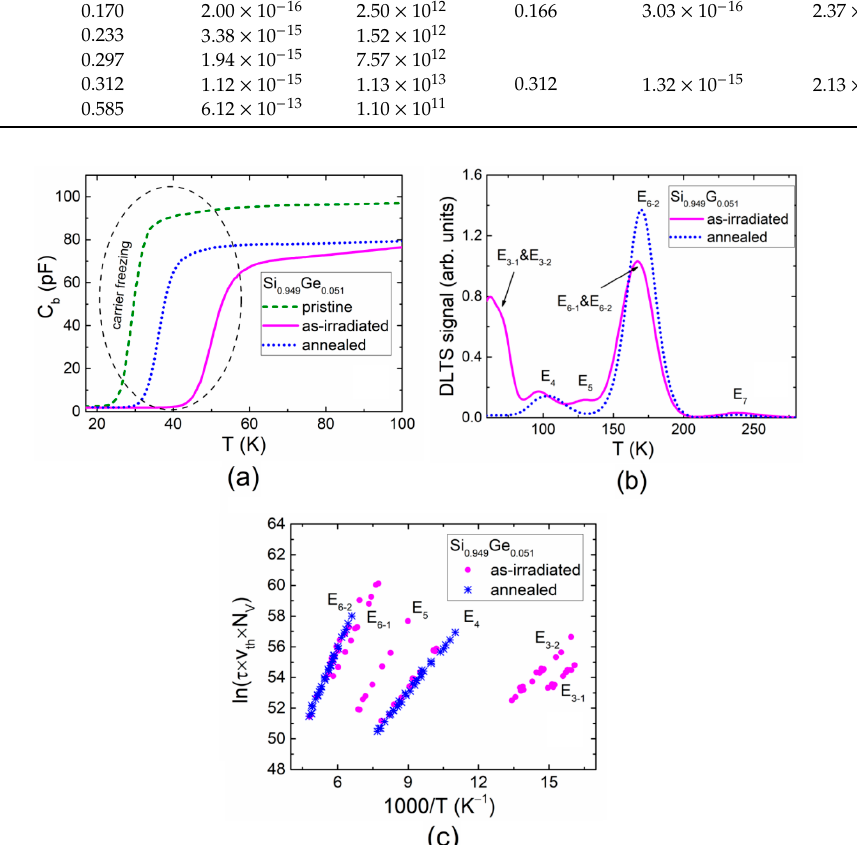
Figure 3. ( a ) The barrier capacitance dependence on temperature (C b –T) obtained for pristine, 5.5 MeV electron irradiated and the subsequently annealed Si 0.949 Ge 0.051 samples. ( b ) DLT spectra recorded on the as-irradiated and annealed Si 0.949 Ge 0.051 samples. ( c ) Arrhenius plots made for different traps.